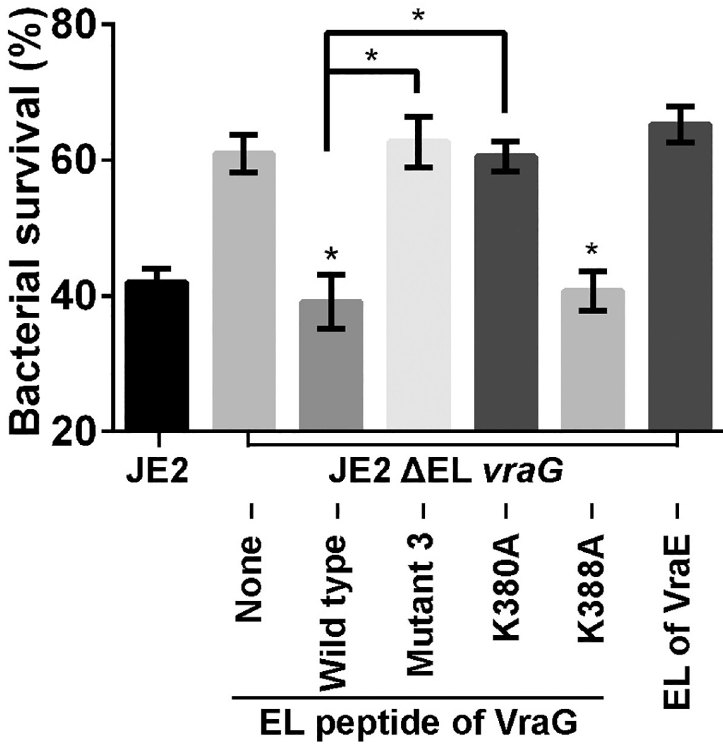
Fig 6. 2 hr. killing assay of Δ EL vraG mutant in LL-37 with exogenous EL peptides. Δ EL vraG mutant cells of JE2 grown to the mid-log phase were incubated with 300 ng of assorted EL peptides of VraG (about 60 nM with 2 X 10 5 cells), followed by treatment with 2.5 μ g/m of LL-37. Lanes counting from left: 1) JE2; 2) Δ EL vraG mutant without EL VraG peptide; 3) Δ EL vraG mutant with native EL peptide; 4) Δ EL vraG mutant with mutant 3 EL peptide (K380A & K388A); 5) Δ EL vraG mutant with K380A EL peptide; 6) Δ EL vraG mutant with K388A EL peptide; 7) Δ EL vraG mutant with EL of VraE. The two lower asterisks � represent p < 0.05 of Δ EL vraG mutant with wild type or K388A peptide vs. Δ EL vraG mutant with no peptide. The two upper astericks � denote p < 0.05 of JE2 Δ EL vraG mutant with mutant 3 or K380A EL peptide vs. Δ EL vraG mutant with wild type EL peptide. Analysis was done by